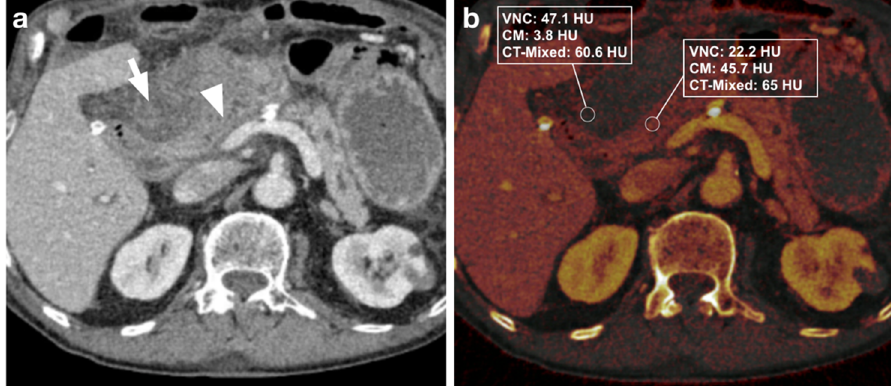
Figure 4. ( a ) 81-year-old male patient with intra-abdominal hematoma (arrow) adjacent to a small bowel loop (arrowhead) after Whipple surgery. ( b ) Measurement of iodine maps shows a difference in VNC and iodine values (dual-energy CT) between hematoma and intestinal loops, but no